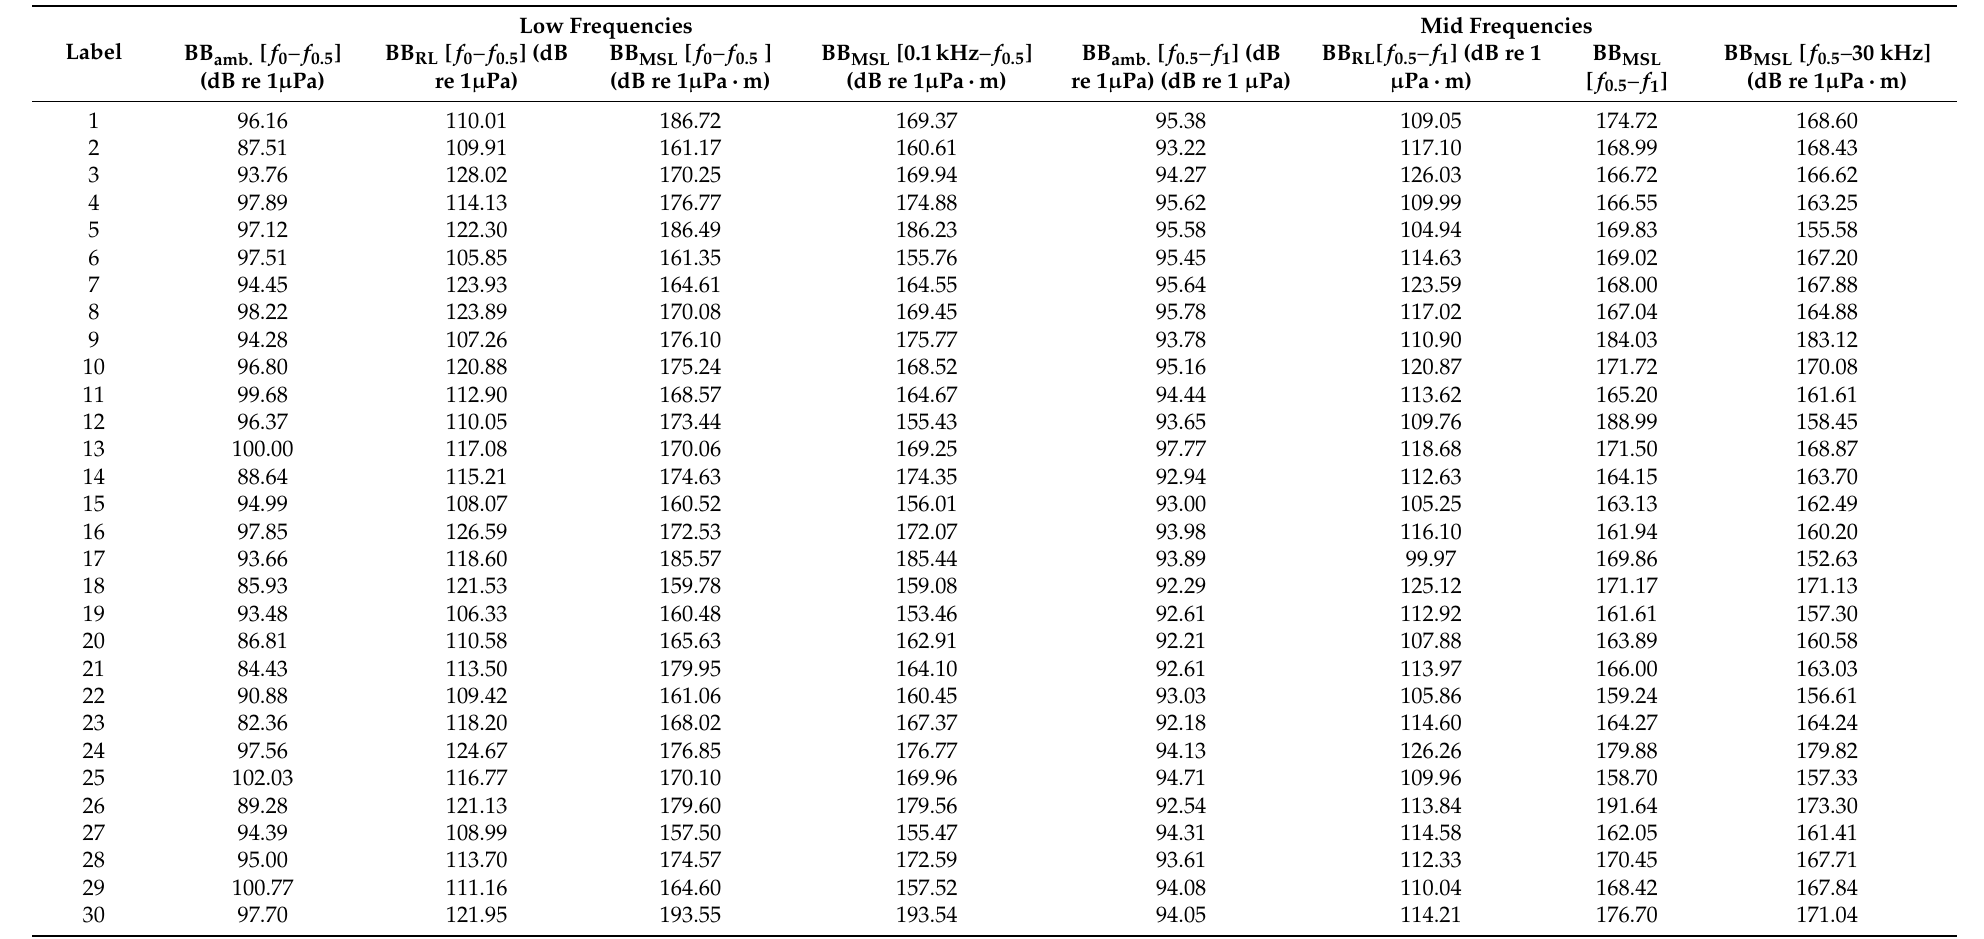
Table 2. Broadband Measurements of Isolated Small Recreational Vessels. Col. 1: vessel’s ID; same as trajectories in Figure 1. Cols. 2 to 5: ambient, received, full-band source, and restrained band source levels in the low-frequency domain. Cols. 6 to 9: ambient, received, full-band source, and restrained band source levels in the mid-frequency